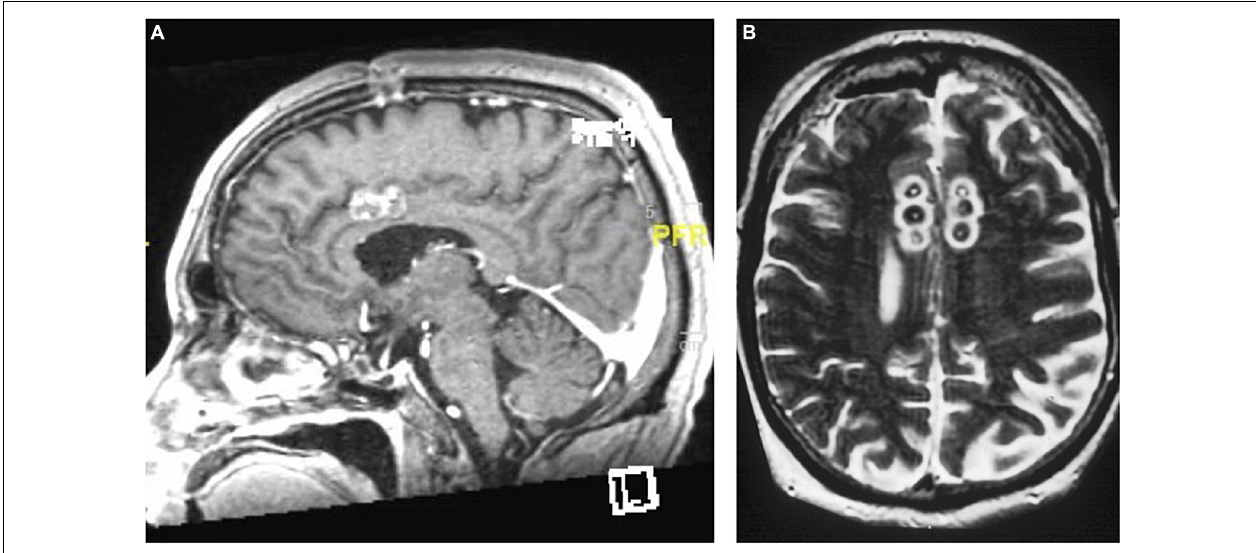
FIGURE 6 | The “six-pack” cingulotomy. (A) Sagittal and (B) Axial T2-weighted MRI of chronic triple lesion cingulotomy.